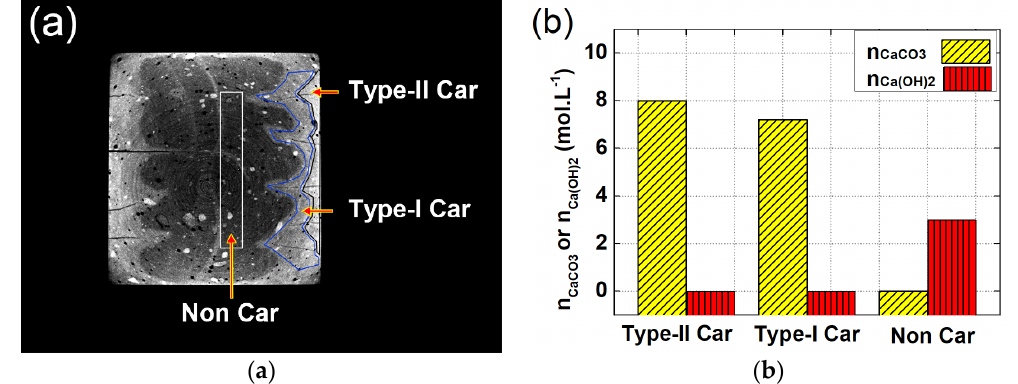
Figure 11. Sampled areas and experimental results for TGA: ( a ) selection of the sampling areas based on rendered CT slice; ( b ) measured CH and CC(cid:3364) concentration from variant local areas.